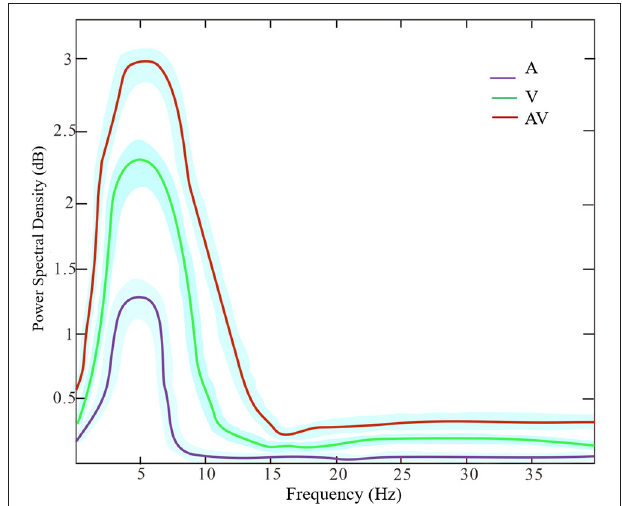
FIGURE 3 | The power spectrum density of frequencies (peak at theta band around 5Hz) across the three encoding conditions (A, V, and AV). The shaded area denotes the standard deviation.